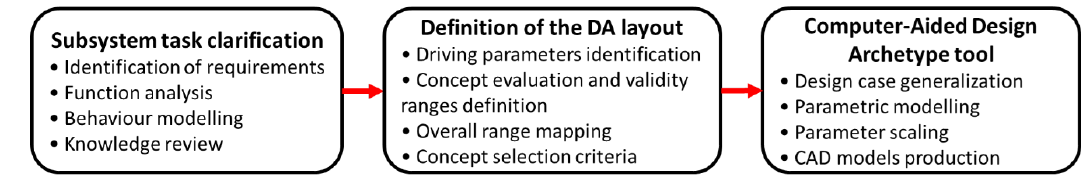
Figure 2. Method phases for the development of a design archetype.